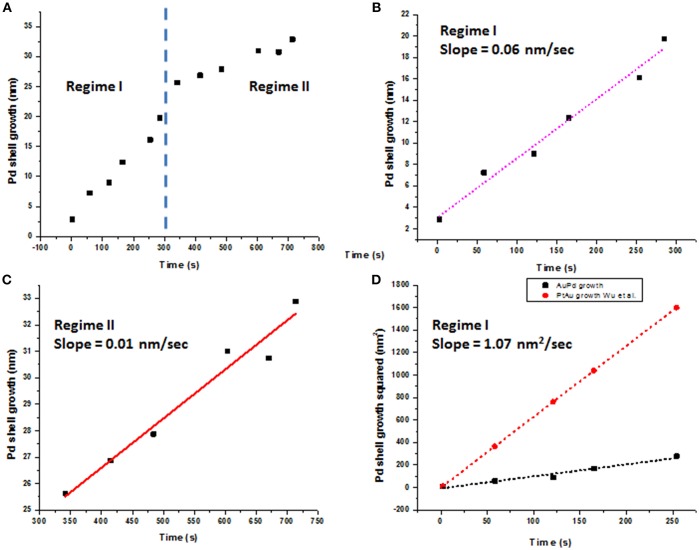
Pd shell growth plotted as a function of time. (A) Pd shell growth exhibits two distinctly different growth rates, denoted as Regime I and Regime II; (B) Linear plot of Pd shell thickness (nm) vs. time (s) in Regime I with a slope of 0.06 nm/s; (C) linear plot of Pd shell thickness (nm) vs. time (s) for Regime II with a slope of 0.01 nm/s; (D) Growth rate in Regime I fitted as d2 = KRt for the reaction-limited growth, with KR value 1.07 nm2/s. Au-Pt growth from the recent report by Wu et al. (2015) is shown for comparison.